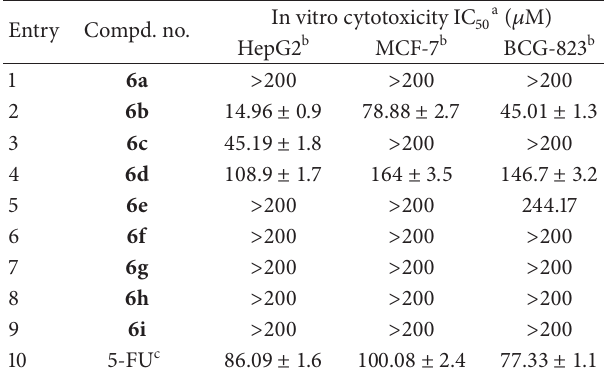
Table 2: Cytotoxicities of target compounds 6a–i against various cancer cell lines.